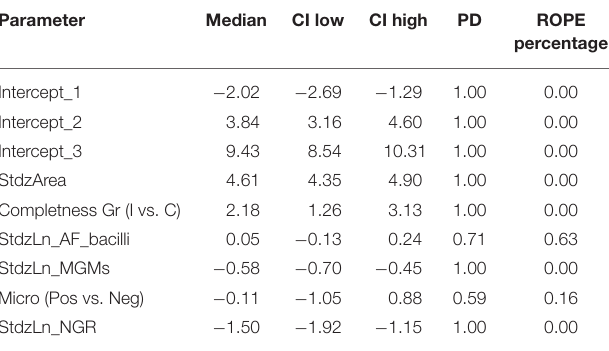
FIGURE 2 | Bayesian posterior distribution of estimated coefficients of the influence of the considered variables on the LNs’ microbiological status. For each predictor, the area corresponding to the values with a negative or a positive effect on the LN microbiological status is shown. G1, 2, 3, 4, proportions of granulomas of the different LN stages; AF, acid-fast; MGMs, multinucleated giant macrophages. TABLE 2 | Influence of the considered variables on granulomas histological stage.